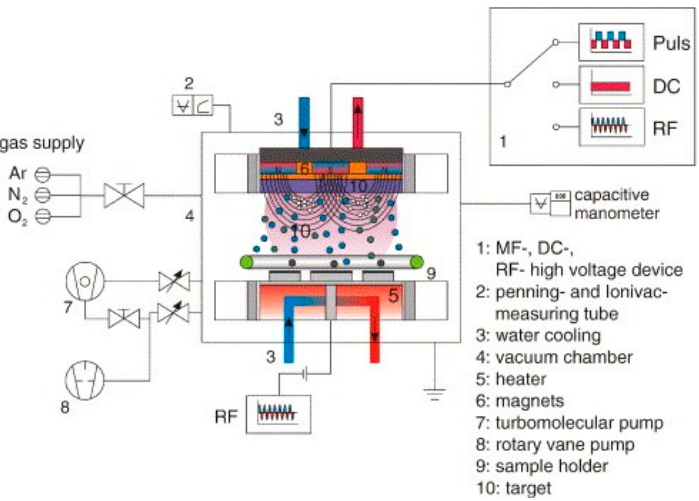
Figure 22. The fundamental parts of radio frequency magnetron sputtering process include radio frequency device, penning, ionivac measuring tube, water cooling, vacuum chamber, heater, magnets, pumps, sample holder, and target. Argon, nitrogen, and oxygen are the three gases used as an input through gas supply inlet [195].